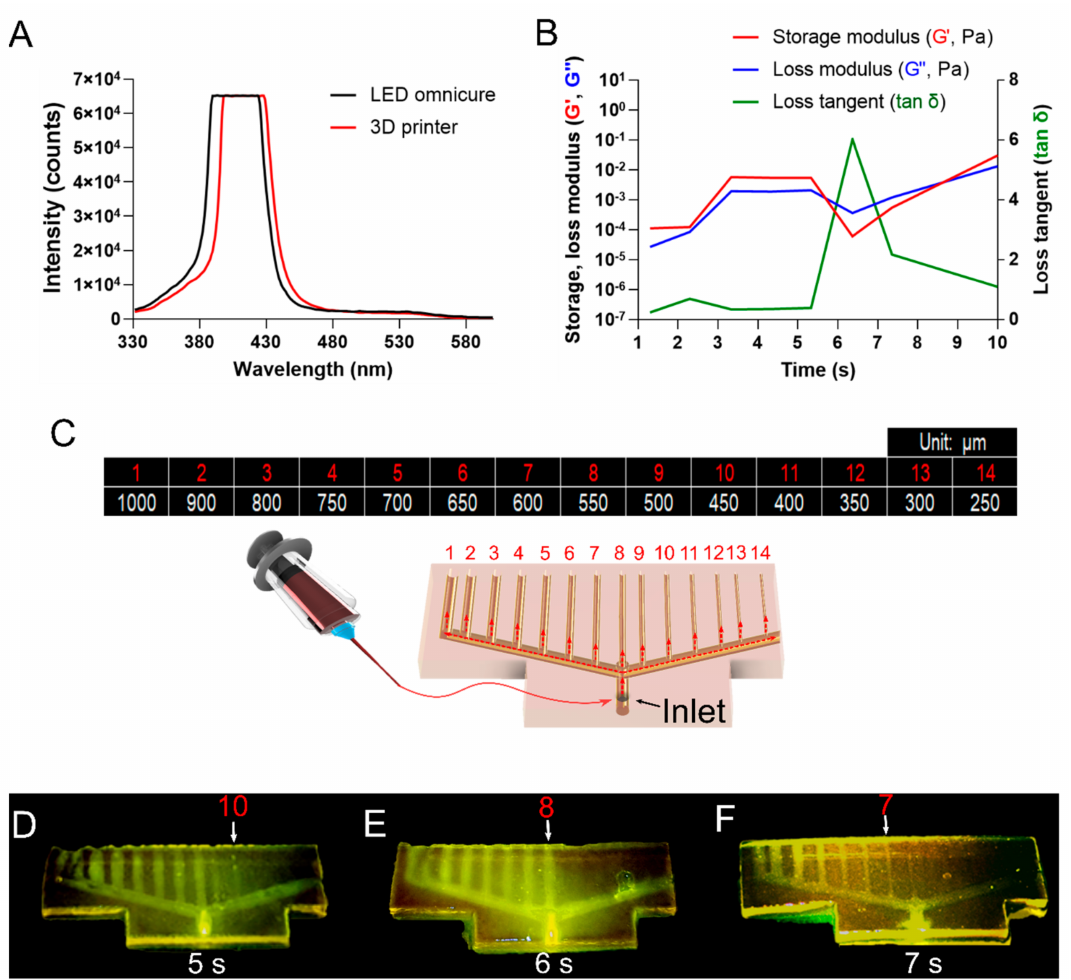
Figure 3. ( A ) Comparison of wavelength bands of output light by Z-stack bioprinter and LED OmniCure. ( B ) Photo-rheological property of the bioink. ( C ) Schematic showing the printing accuracy analysis model of hollow tubes with 14 di ff erent diameters. The table shows the diameter of each hollow tube. ( D – F ) Images of the sca ff old printed models at di ff erent light exposure times: 5, 6, and 7